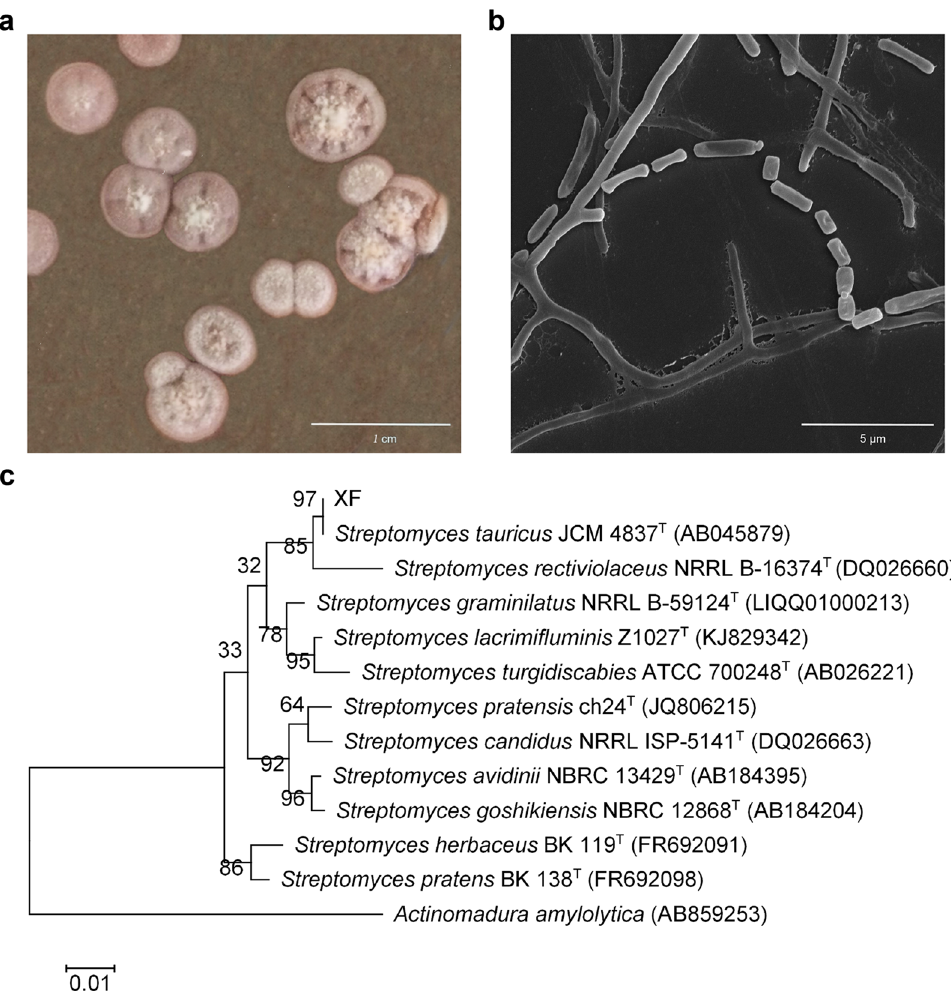
Fig. 2 Identification of XF. a The morphological feature of XF on Gause’s Medium (GM). Bar spore chain. Bar 5 μm. c Phylogenetic tree based on the partial nucleotide sequence of 16S RNA genes. Numbers between segments represent = bootstrap support values, and ‘T’ above represents the strain as a model